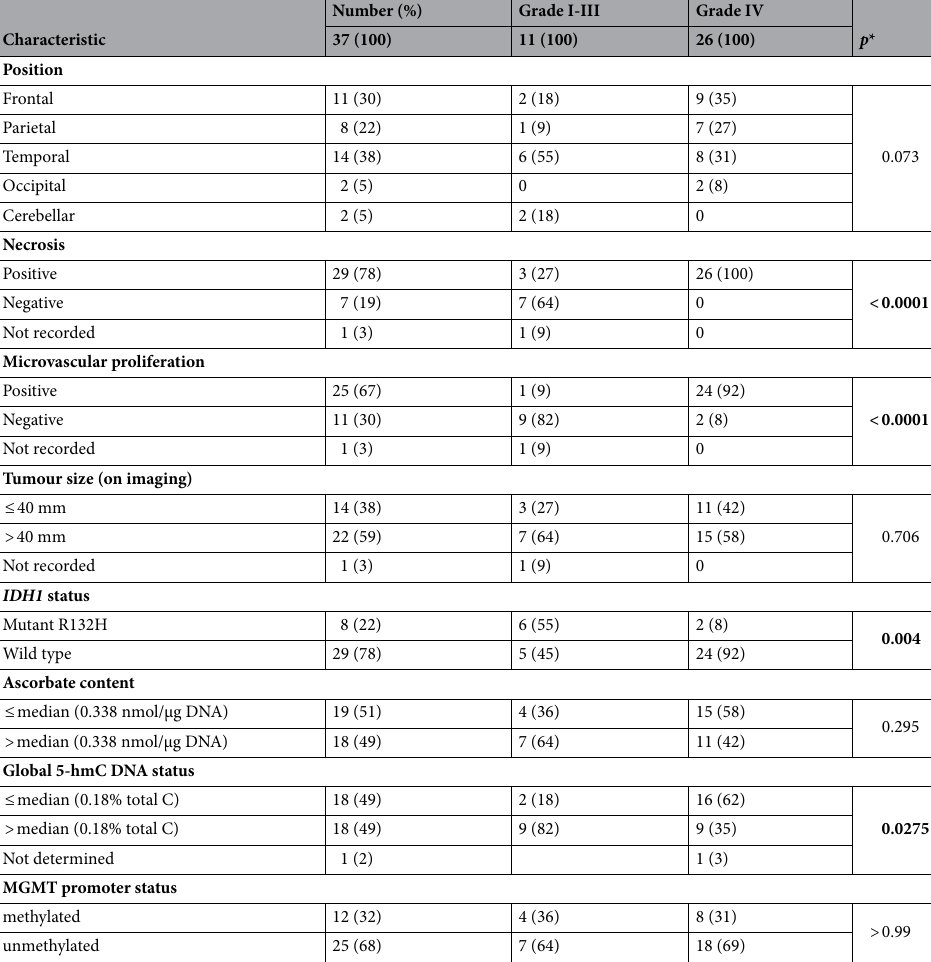
Table 2. Clinicopathological and molecular characterisation of glioma tumour samples. *Comparison of grade I–III versus grade IV, Chi-square or Fisher’s exact test, * bold indicates significant p